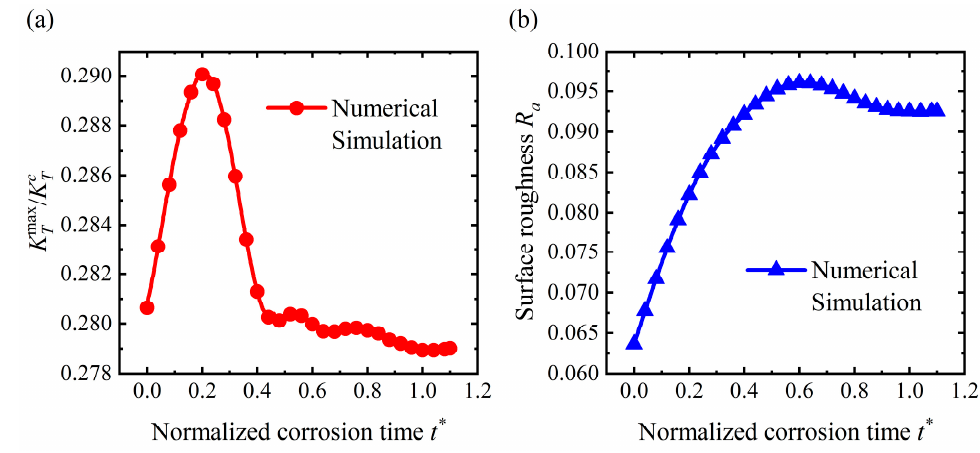
Figure 13. Evolution of ( a ) the maximal stress concentration factor and ( b ) surface roughness during corrosion when A ∗ = 0.1 and σ A = 19